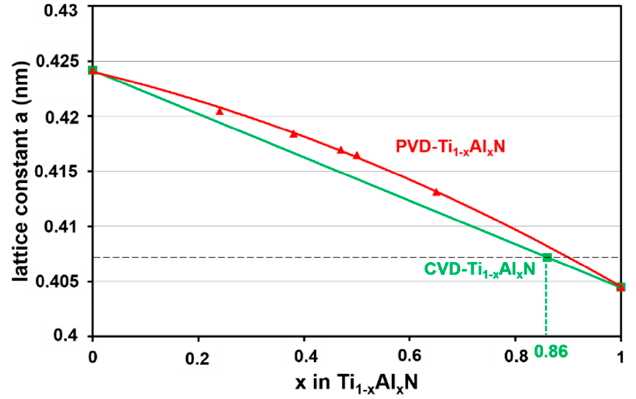
Figure 4. Lattice constants of fcc-Ti 1 − x Al x N layers as function of x according to Vegard‘s law for PVD layers and for the fcc-Ti 1 − x Al x N phase in the CVD layer of this work. The green line shows the linear Vegard’s plot and the red line presents the progression based on experimental data of PVD layers.